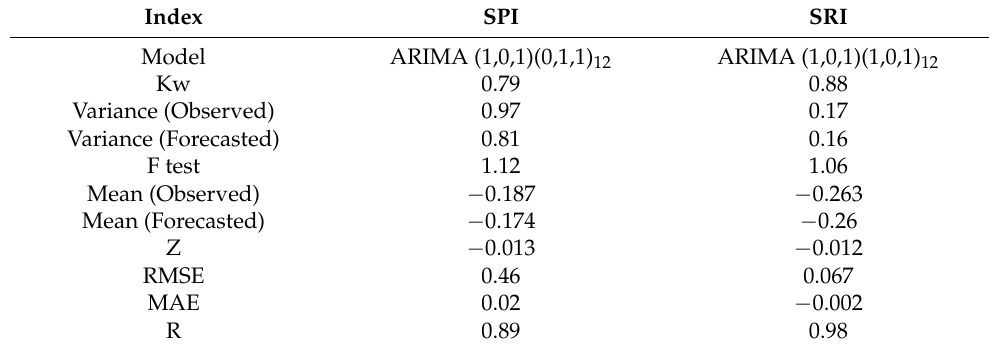
Table 4. Comparison of statistical properties of the observed and predicted data in model